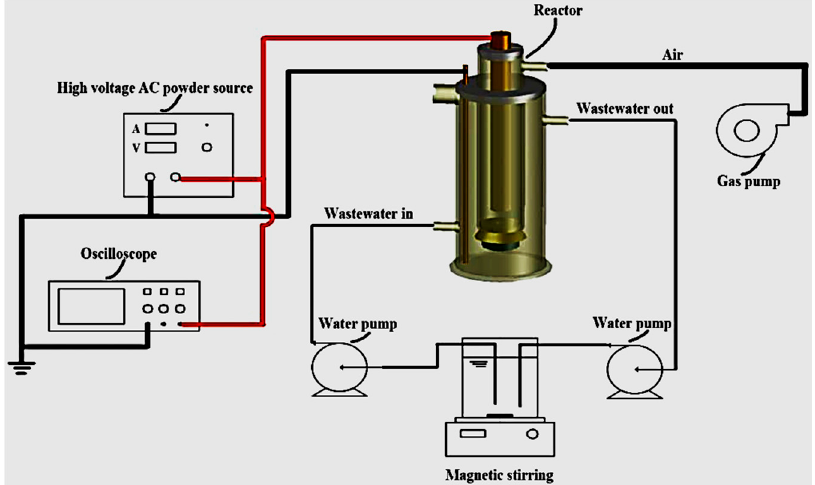
Figure 11. Plasma reactor set up used for the decomposition of acetaminophen (APAP) model pollutant [166].